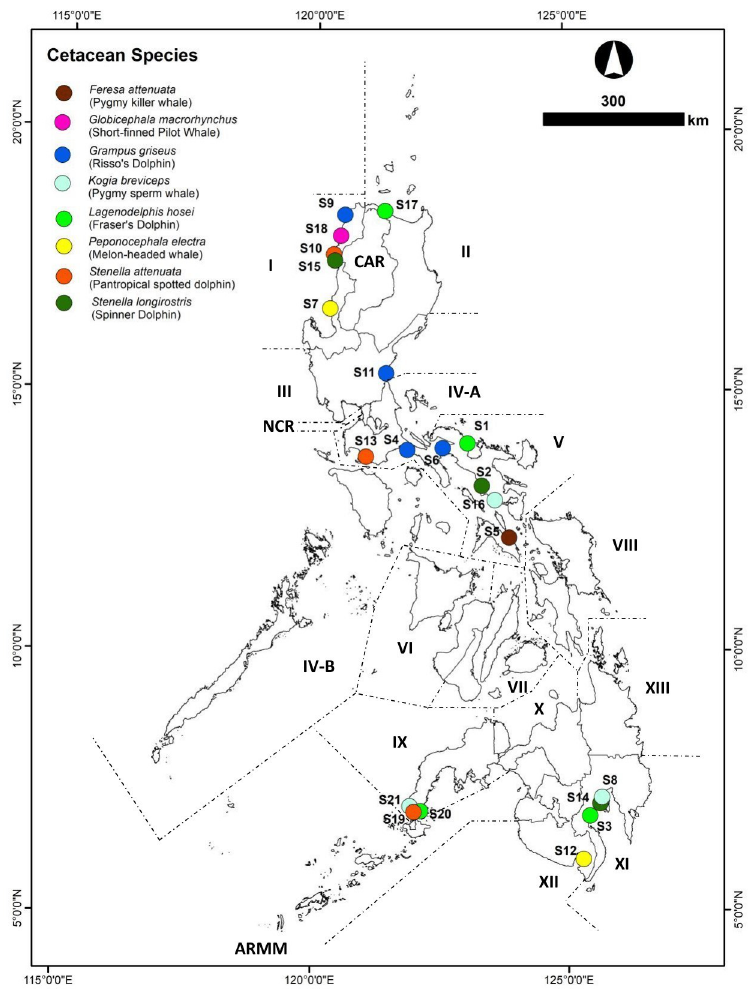
Fig 1. Sites of cetacean stranding events from February 2017-April 2018. S1 –S21: Cetacean Strander Codes; I-XIII, CAR, NCR and ARMM: Administrative Regions in the Philippines (Reprinted from Philippines—Subnational Administrative Boundaries under a CC BY license, with permission from The Humanitarian Data Exchange, original copyright